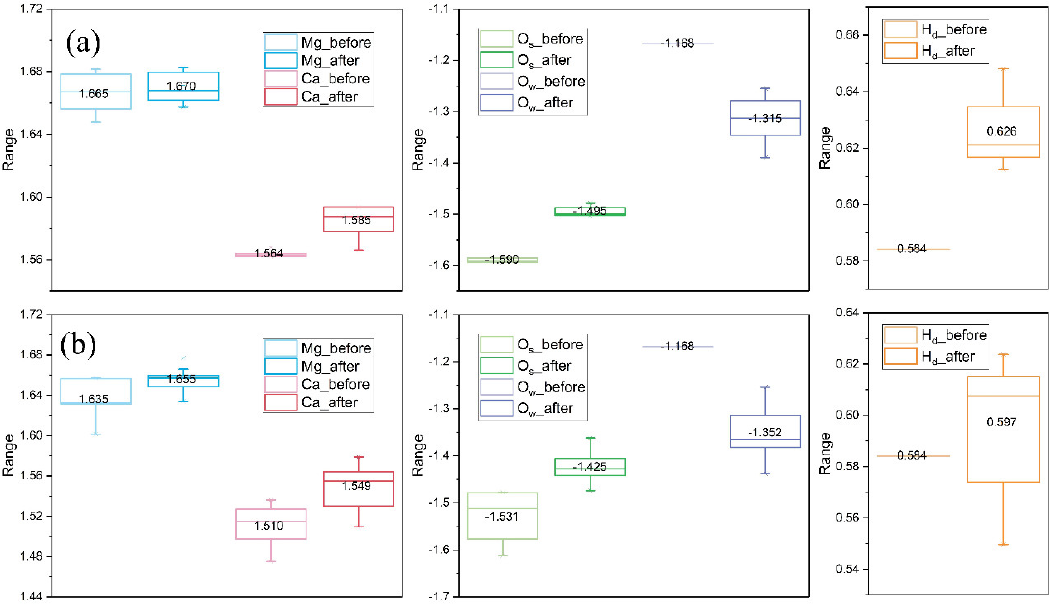
Figure 5. The influence of water adsorption on the Bader charge of surface atoms that were involved in the bond formation: ( a ) β-C 2 S surfaces, and ( b ) M3-C 3 S surfaces. Note: numbers in the box are mean values.